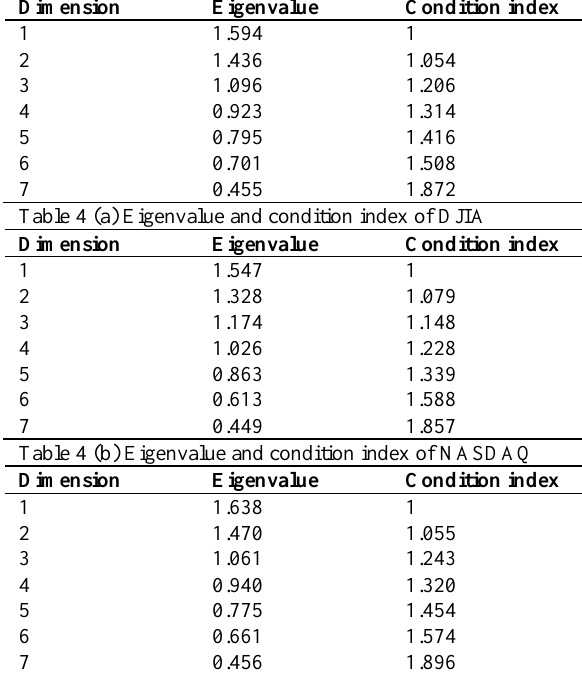
Table 4 (c) Eigenvalue and condition index of S & P